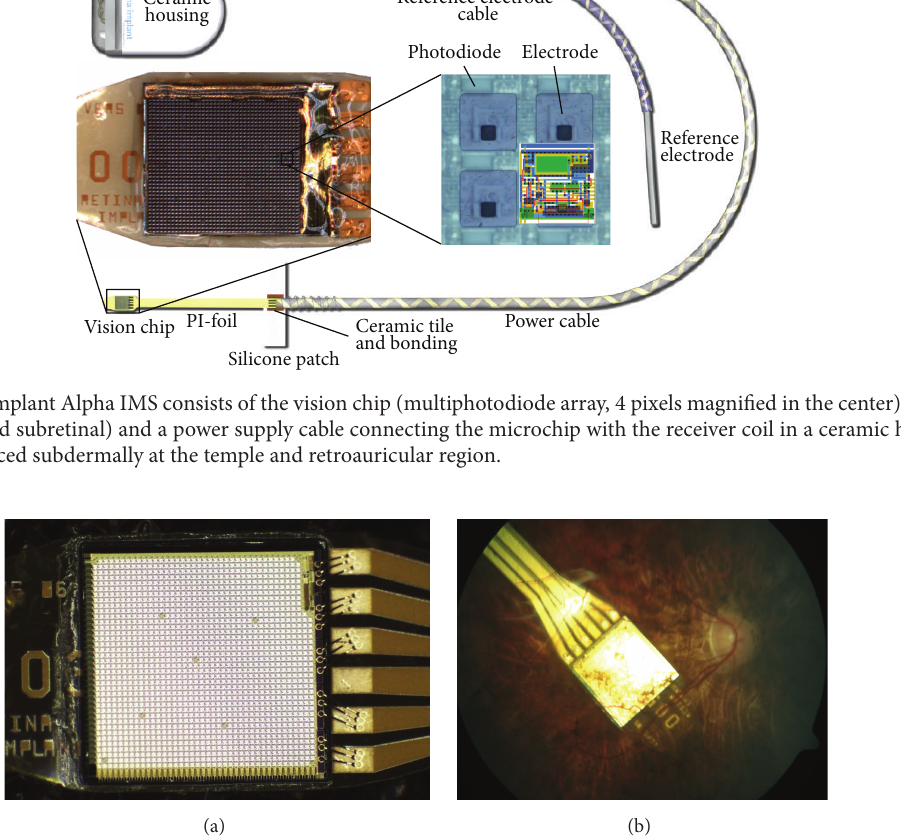
Figure 2: (a) The implant’s core is the light sensitive subretinal chip with 1500 pixels. The chip size is approximately 3 mm × 3mm; it is approximately 70 𝜇 m thin when placed on a polyimide foil (thickness approx. 20 𝜇 m) with gold connective wire prints, which leaves the subretinal space in the upper temporal periphery through the choroid and the sclera. (b) Fundus image of the Retina Implant Alpha IMS.